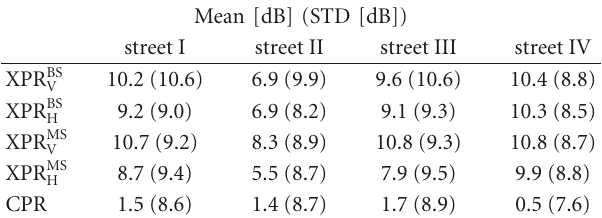
Table 2: XPRs and